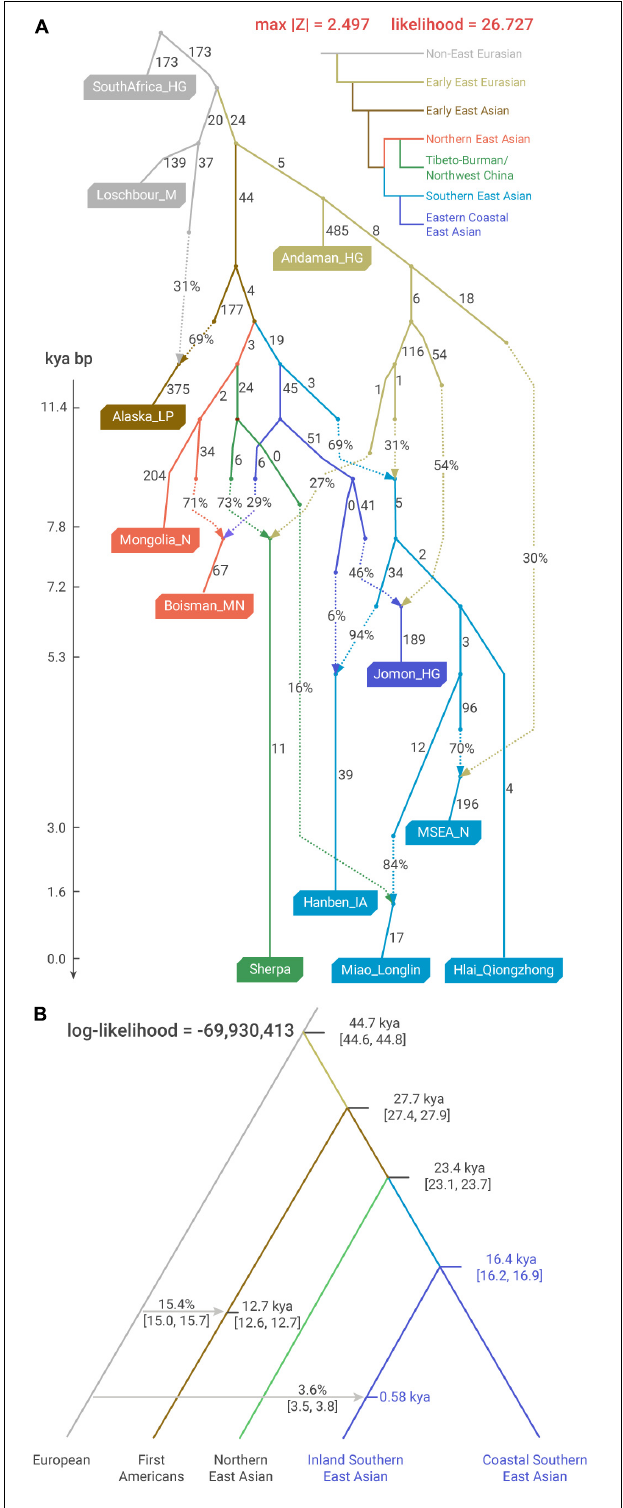
FIGURE 4 | Demographic modeling for the deep history of East Asians (A) optimal qpGraph admixture model for the phylogenetic relationship among the surrogates for major ancestries in East Asia. Alaska_LP,